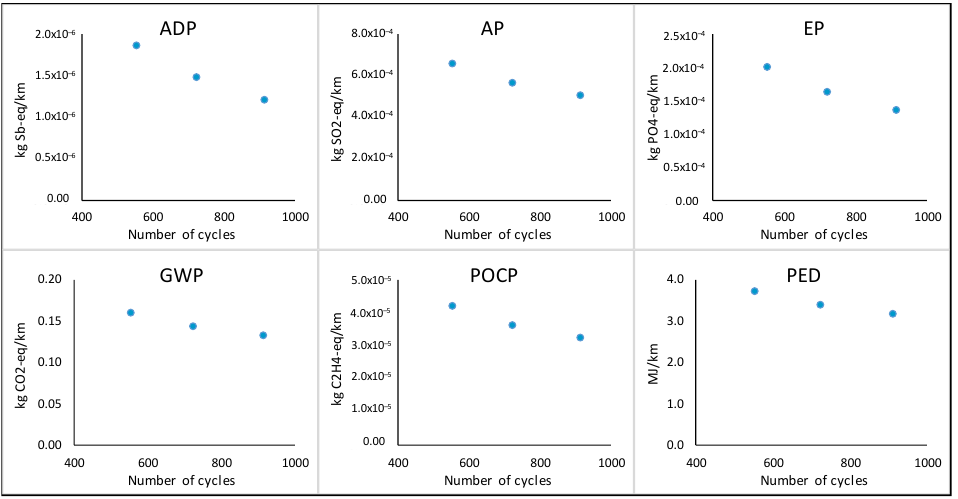
Figure 8. Impact per km for each impact category assessed versus the number of cycles achieved during the lifespan of the battery. Table 7. Life Cycle Impact Assessment (LCIA) results per functional unit and per reference flow.